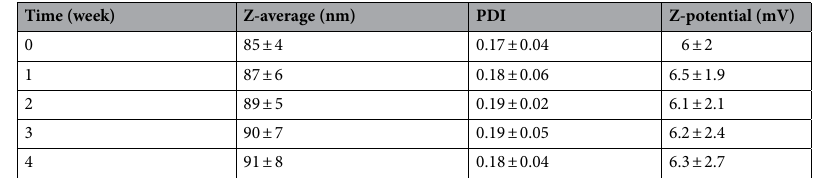
Table 2. Monitoring the size, PDI, and zeta potential of Liposomal CD73 siRNA (DOTAP: DOPE: Cholesterol: mPEGDSPE (10.08 mM)) during 4 weeks storage period in the refrigerator. All data are presented as mean ± SD of three independent experiments. PDI Poly Dispersity Index.